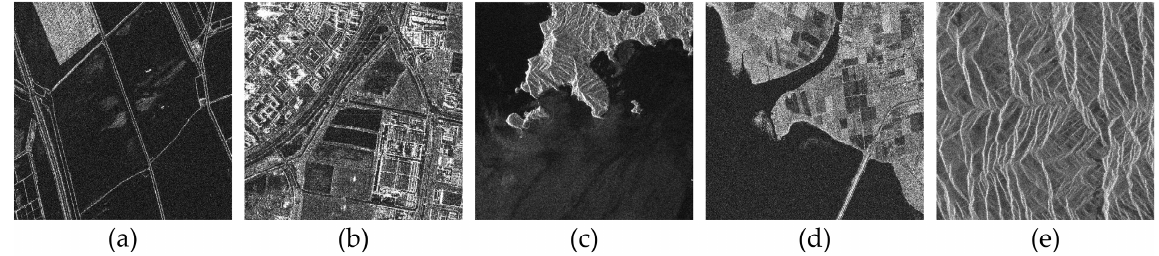
Table 1. Parameters of selected real SAR images. Sensors Bands Polarization Resolution GF-3 C